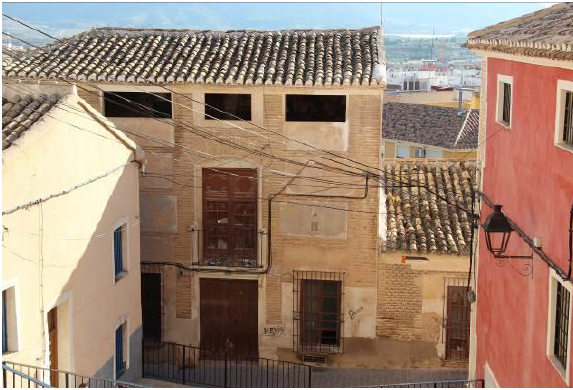
Figure 10. Mixed rammed earth wall in the dwelling on calle Sastres no.7 (Source: authors).